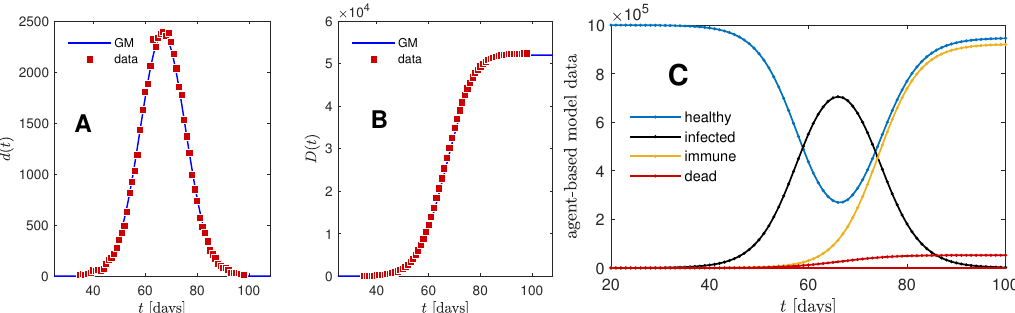
Figure A1. Representative result of our stochastic agent-based model. Model parameters: P = 10 6 individuals, a = 15 days, b = 5 days, c = 0.05, and f = 0.05. There is no hint for an asymmetry to be taken into account and the GM describes the data for ( A ) daily fatalities and ( B ) cumulative fatalities very well. For this case the fitted GM parameters are t d,max = 66.8, d max = 2370, and w = 12.4 days. ( C ) Additional information available from the same simulation run, as described in the text part. Red data for cumulative fatalities D ( t ) is identical in ( B , C